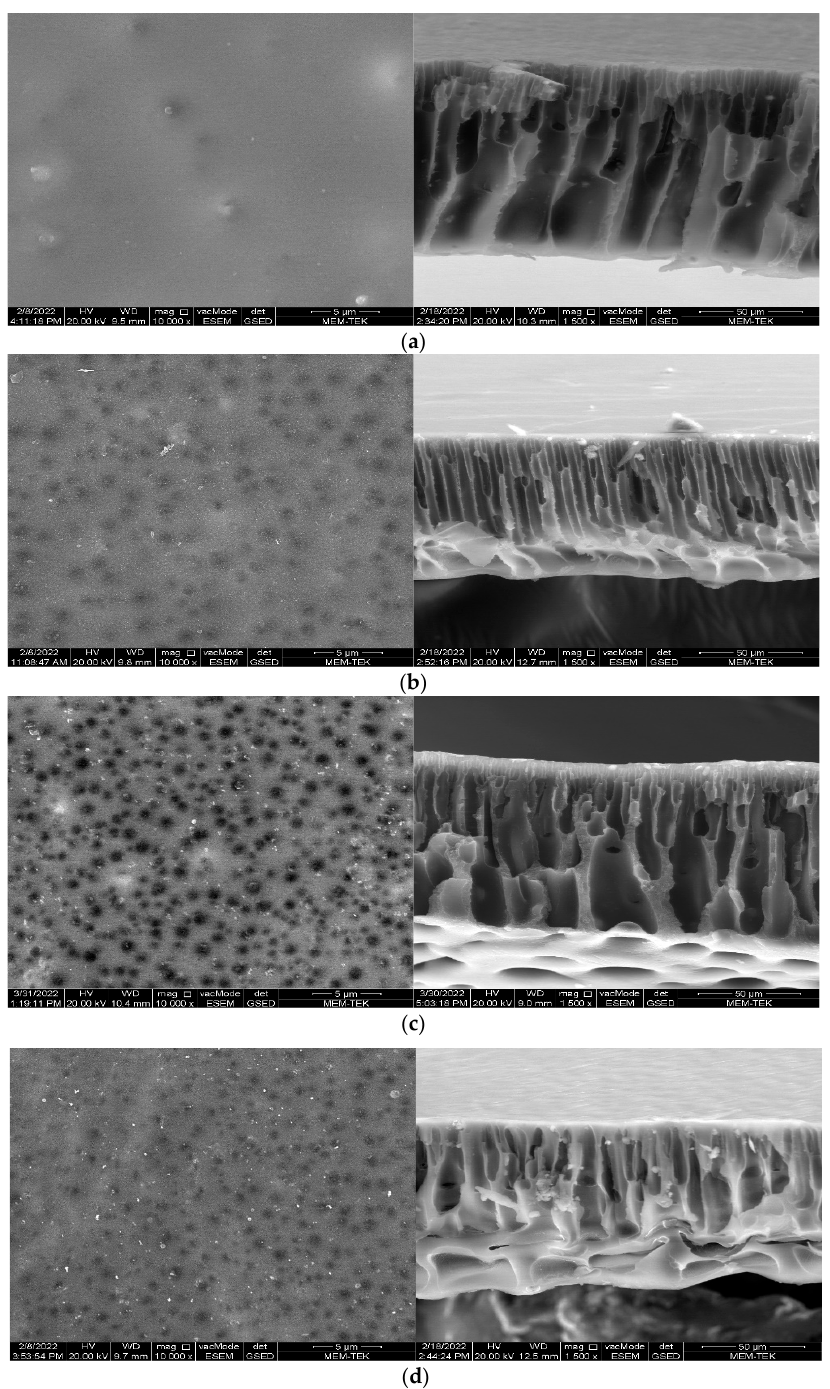
Figure 5. SEM surface and cross-section views ( a ) PAN, ( b ) 0.1% FS-doped PAN, ( c ) 0.5% FS-doped PAN and ( d ) 1% FS-doped PAN. PAN and ( d ) 1% FS-doped